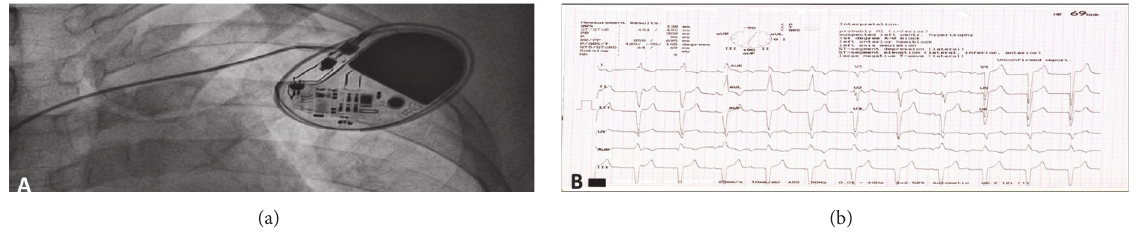
Figure 2: (a) Image showing implanted permanent pacemaker; (b) electrocardiogram after implantation of